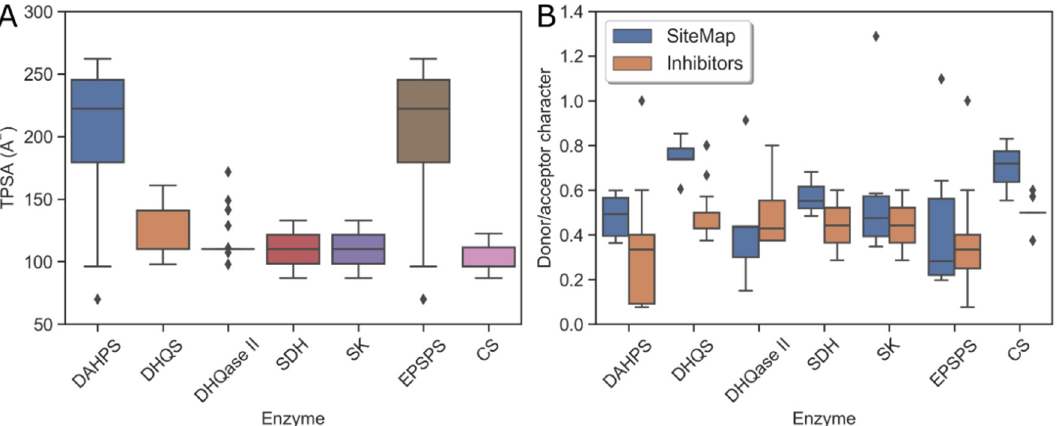
Figure 7. Physicochemical properties of the substrate-binding sites and the available inhibitors. ( A ) Median TPSA of inhibitors per enzyme; ( B ) proton donor/acceptor character of inhibitors compared to binding sites per enzyme.